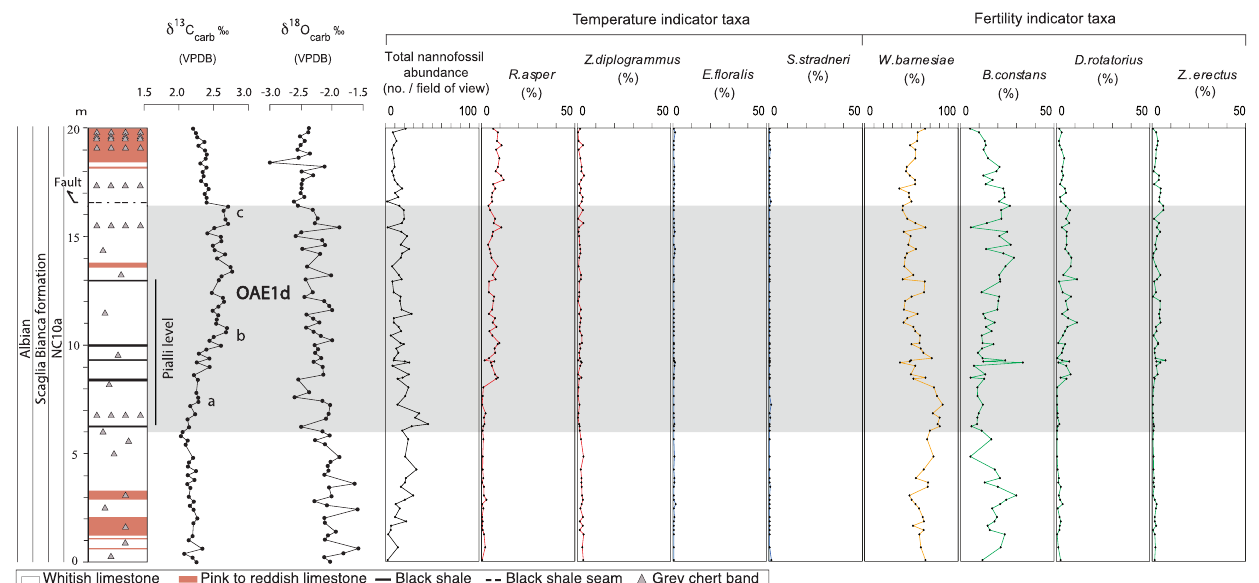
Clim. Past, 14, 1147–1163,